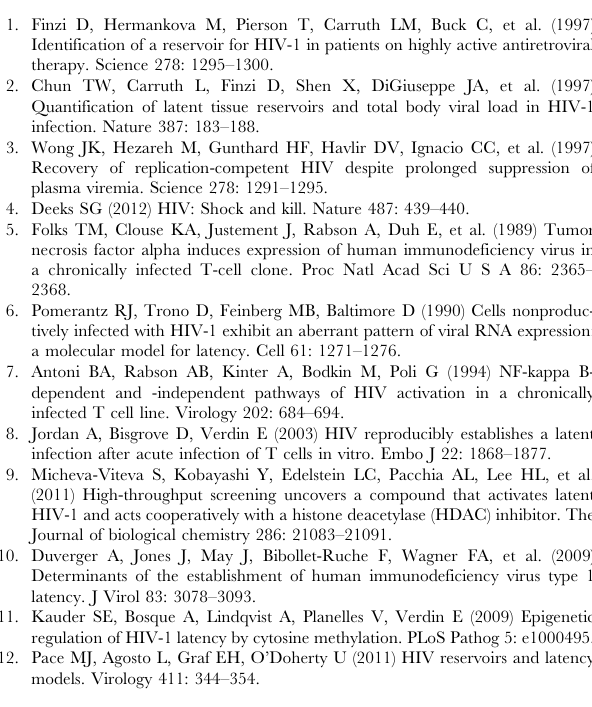
Figure S1 Levels of HIV induction are plotted for each stimulus tested in each cell model. Within each model, results have been normalized to the maximal response of a positive control stimulus response for each stimulus is shown, independent of the stimulus concentration associated with the response. Positive responses are rounded to the nearest decile percentage. Open bars indicate a response below 5%. Figure S2 TNF- a receptor is not expressed in freshly isolated memory CD4 + cells and is extremely low in cultured central memory cells. Gray curves and black lines represent cells stained with isotype control and TNFR antibody, respectively. J-Lat clone 10.6 was used as a positive